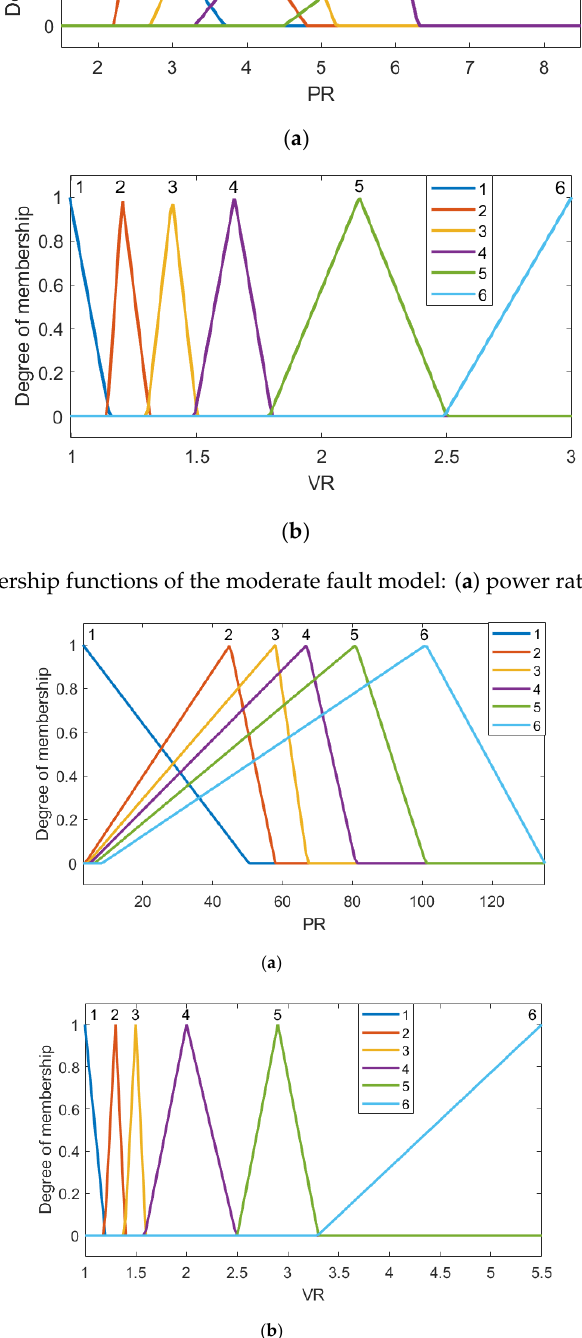
Figure 11. Membership functions of the major fault model: ( a ) power rate, ( b ) voltage rate. After selecting the linguistic variable and identifying the region of the fuzzy set, the fuzzy rules were required to be set. The initial rule sets for the three fuzzy models are illustrated in Table 4. The presented Sugeno fuzzy models were utilizing the product as an intersection method and the weighted average as a defuzzification method. Moreover, as shown in Table 4, the rules had been weighted during the tuning process, in order to select a single winner rule in the classification phase.